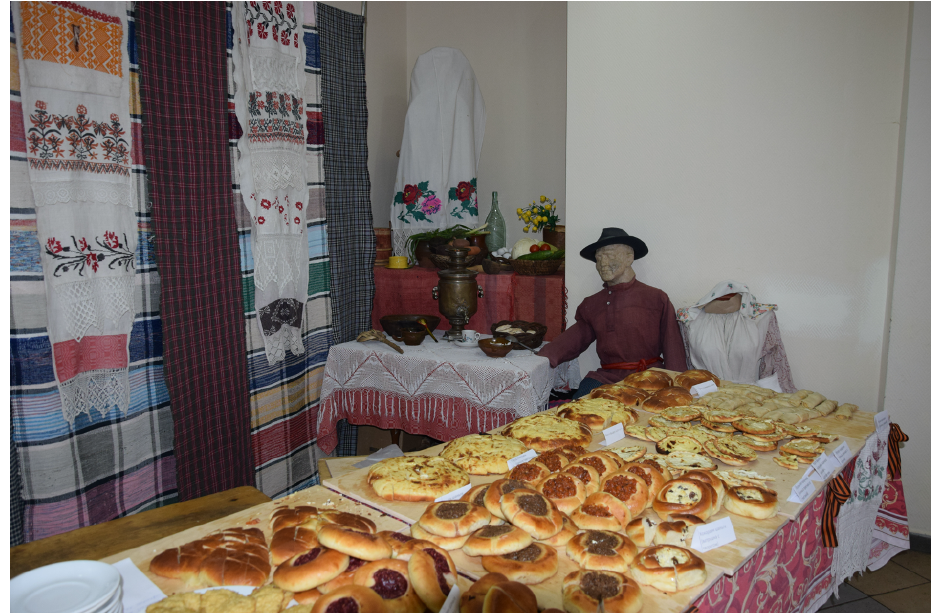
Figure A2. “Days of Udmurt Cuisine” in the Sharkansky District. Source: compiled by the authors based on [65].